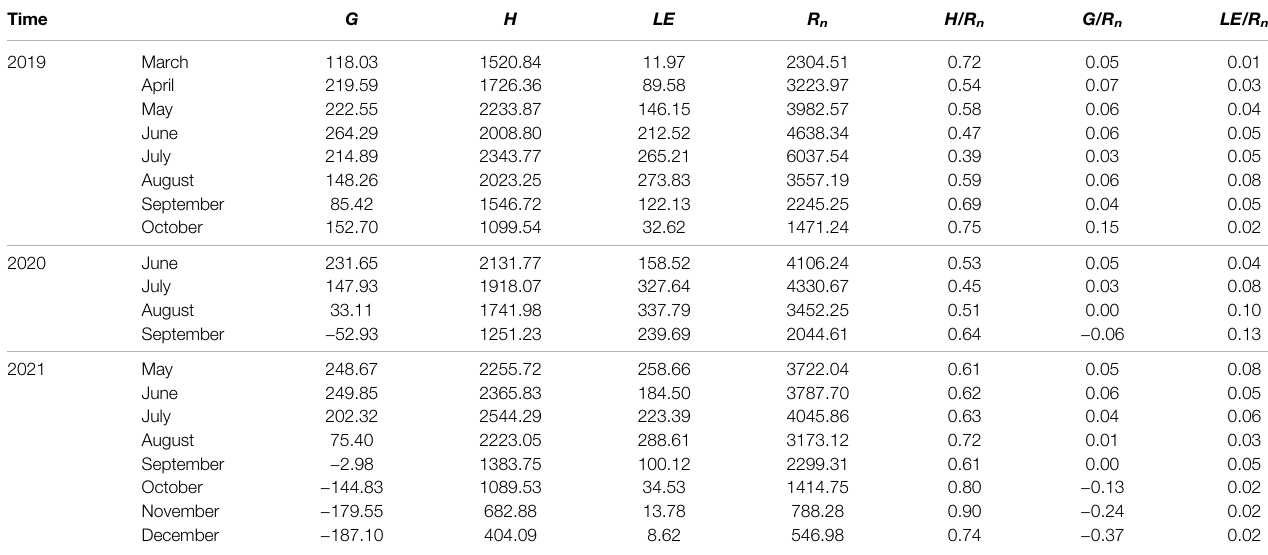
TABLE 2 | Monthly total amount of daily average energy components (W m − 2 ) and energy distribution in a desert ecosystem in Dengkou County (Inner Mongolia) during the observation period. Time G H LE R n H / R n G / R